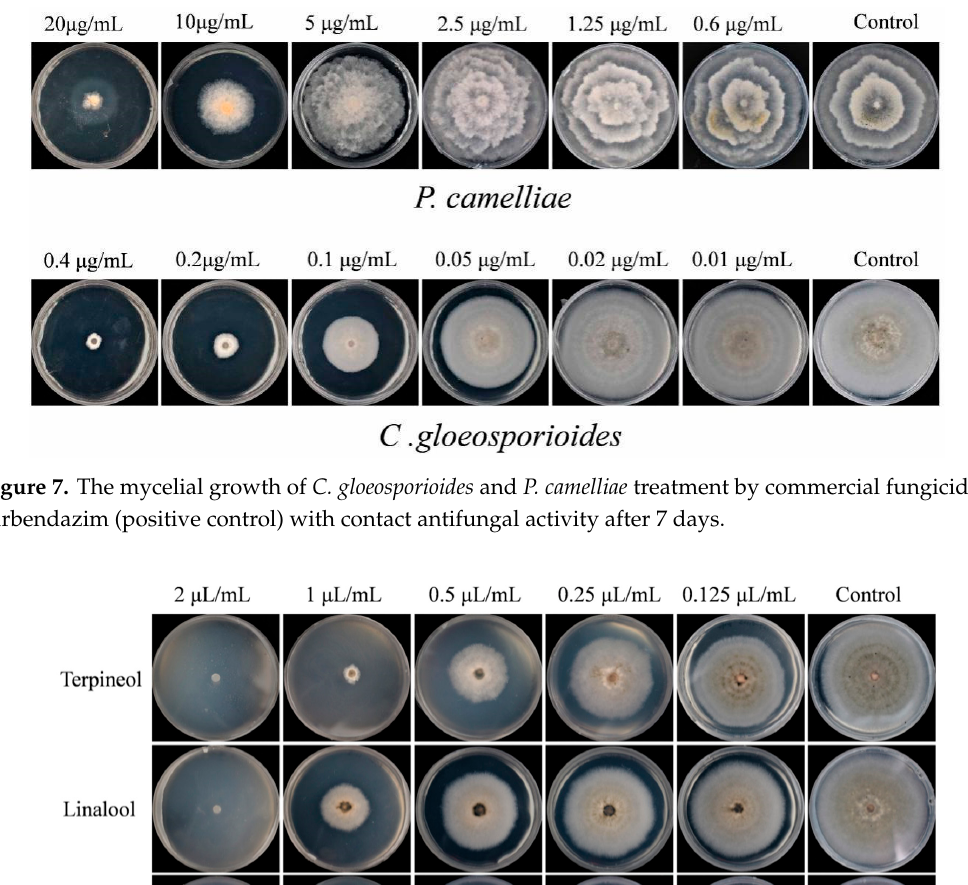
Figure 6. The mycelial growth of P. camelliae treatment by four mainly activity compounds with contact antifungal activity after 7 days.